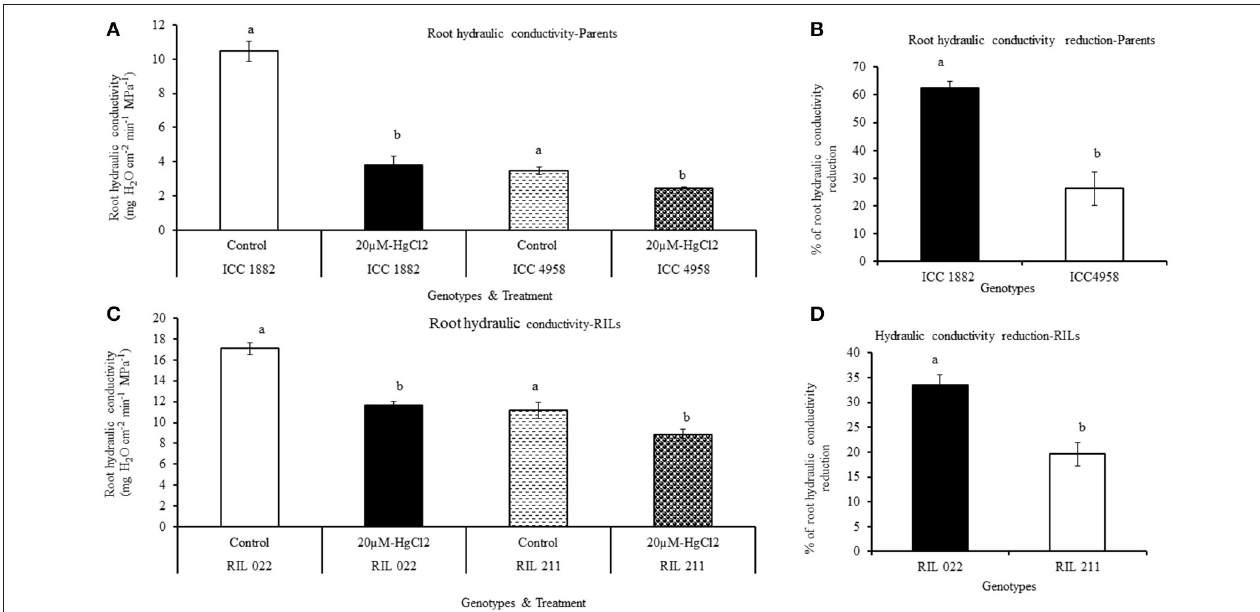
FIGURE 7 | Differences root hydraulic conductivity in de-topped plants of four chickpea genotypes after aquaporin inhibition [20 µ M-HgCl 2 ]. Hydraulic conductivity under controlled and treated (inhibited) conditions were represents in graph (A,C) and also open bars represents ICC 1882 and RIL 022 and open bars filled with dashed lines represents ICC 4958 and RIL 211. The same graph (A,C) closed bars represent ICC 1882 and RIL 022 and closed bars filled with dotted spot represents ICC 4958 and RIL 211. The graph (B,D) represents percentage of hydraulic conductivity reduction parents and progenies. Each bar data represents the root hydraulic conductivity means ( ± SE) of eight replicates per genotype. Bars with different letters are significantly different ( P = 0.05).